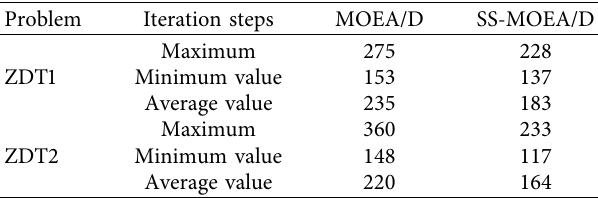
Table 1: Comparison of iteration steps.